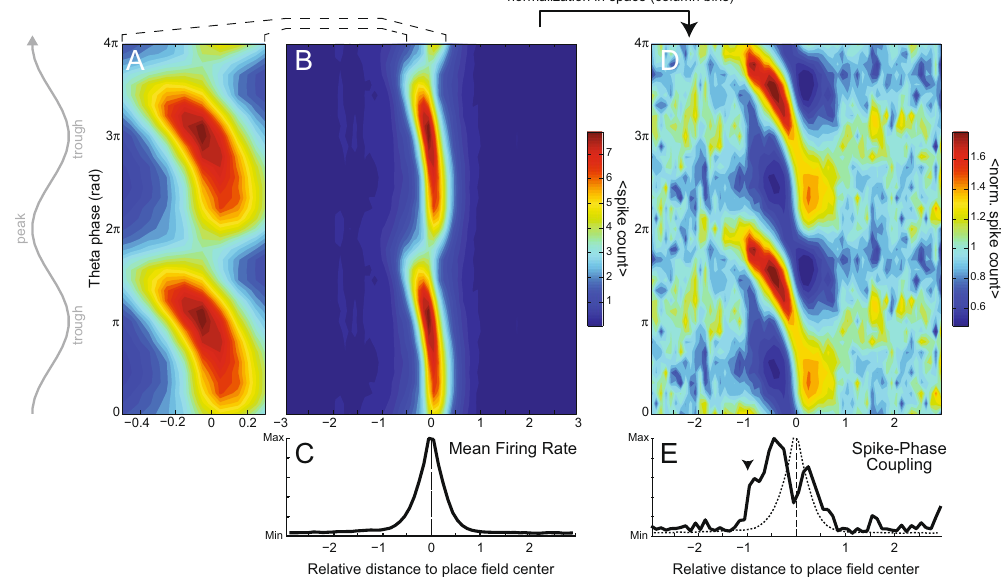
Figure 2. Place cells couple to theta phase before increasing their firing rate. ( A ) Average spike count per relative distance and theta phase (n = 1071 place fields), showing the characteristic phase precession (2 π is the peak of theta recorded from the CA1 pyramidal cell layer). ( B ) Zoomed-out view of the data in ( A ). ( C ) Mean firing rate as a function of relative distance. ( D ) Same data as in ( B ), normalized by the mean number of spikes at each position. ( E ) Spike-phase coupling strength per relative distance (solid line); the dashed line reproduces the firing rate in ( C ). Notice that place cell spikes align to a preferred theta phase before major increases in firing rate